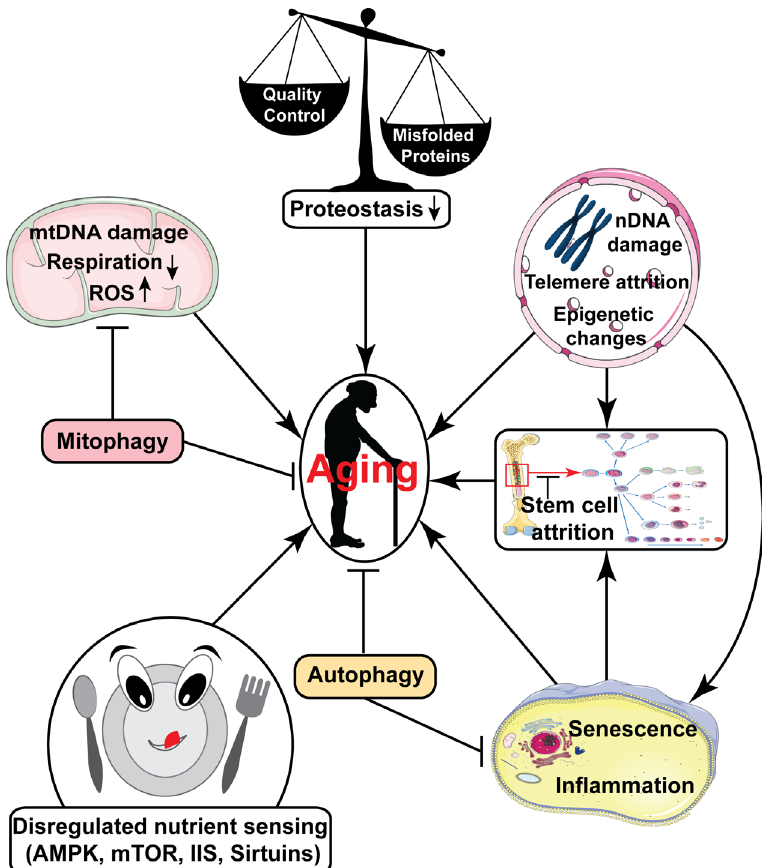
Figure 1. Summary of various factors that may contribute to aging. Dysregulation of nutrient-sensing pathways, mitochondrial dysfunction, loss of proteostasis, stem cell attrition, accumulated DNA damage, reduced autophagy, accumulation of senescent cells, and increased sterile inflammation are some important pathways thought to drive aging 1